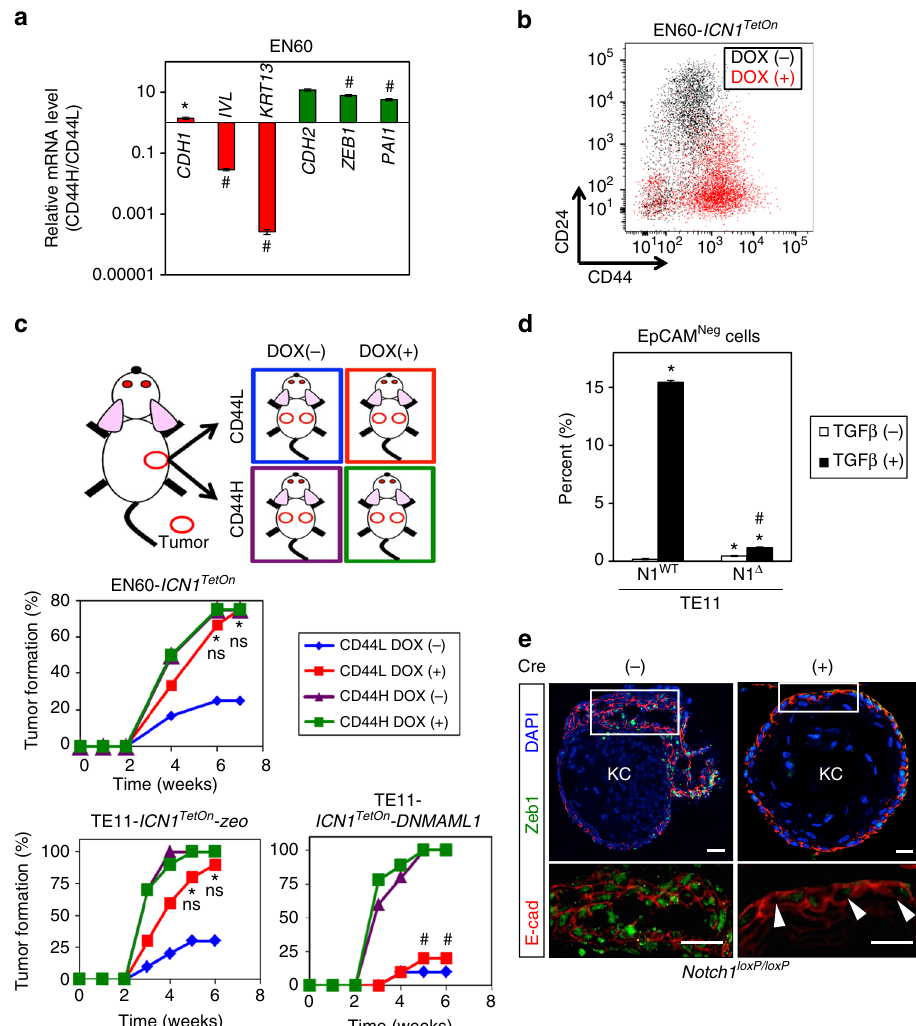
Fig. 3 Notch1 facilitates expansion of CD44H cells with mesenchymal properties. a qRT-PCR analysis for indicated genes comparing EN60 intratumoral CD44L and CD44H cells. * P < 0.05 vs. CD44L; # P < 0.0001 vs. CD44L; n = 3 per group. b Representative fl ow cytometry scatter plot determining CD44H cells in EN60 tumors grown for 4 weeks with or without DOX-induced ICN1 (EN60- ICN1 TetOn ). c Experimental design of serial transplantation experiments and tumor formation rates by CD44L and CD44H cells puri fi ed from parental xenograft tumors carrying DOX-inducible ICN1 (EN60- ICN1 TetOn and TE11- ICN1 TetOn ). Parental tumors were grown in mice without DOX treatment and dissociated for FACS-puri fi cation of CD44L and CD44H cells. Puri fi ed cells were serially transplanted (10 3 cells per injection site) into recipient mice to monitor tumor formation. Recipient mice were treated with or without DOX. TE11 carried DNMAML1 or zeo (empty vector control). * P < 0.05 for CD44L and DOX (+) vs. CD44L and DOX ( − ), n = 10 – 12 per group; ns not signi fi cant for CD44L and DOX (+) vs. CD44H (with or without DOX treatment), n = 10 per group; # P < 0.05 vs. TE11- ICN1 TetOn -zeo CD44L and DOX (+), n = 10 per group. d Flow cytometry analysis for EpCAM-negative cells in TE11 with NOTCH1 deletion (N1 Δ ) or wild-type control (N1 WT ). Cells were treated with or without 5 ng/ml TGF β for 72 h. * P < 0.05 vs. TGF β ( − ); # P < 0.0001 vs. N1 WT and TGF β (+), n = 3. Data are presented as mean ± s.e.m. e Multicolor IF for E-cadherin and Zeb1 in representative single-cell-derived organoids from 4NQO-induced ESCC tumors of Notch1 loxP/loxP mice with or without ex vivo Cre- mediated recombination. Zeb1 expression diminished in organoids upon Cre-mediated Notch1 deletion (arrowheads). Box denotes area that is magni fi ed in panel below. KC keratinized core of organoids. Scale bars, 20 µ m. Bar diagrams represent mean ± s.d. in a , d . At least two independent replicates were performed for all experiments. Student ’ s t -test was used for paired data comparisons in a , d . Chi square with Fisher ’ s exact test was used for